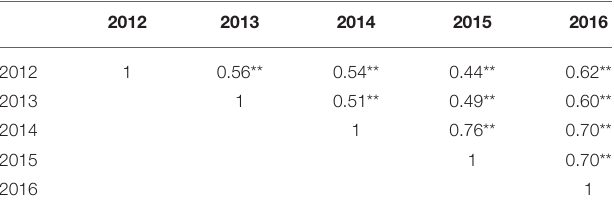
TABLE 4 | Comparison of QTN/QTL identification for different statistical models. Statistical